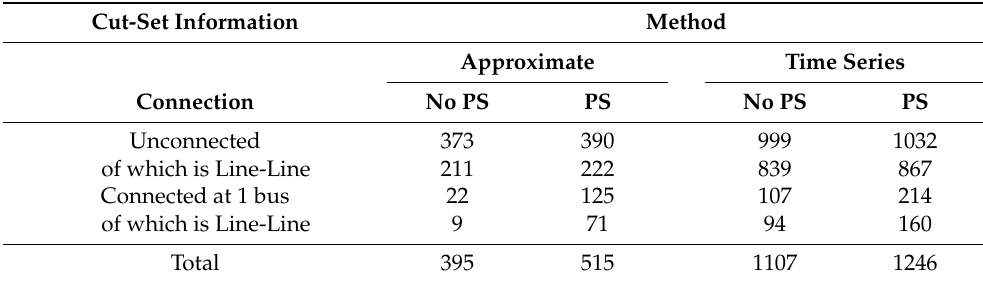
Table 3. Energy Not Supplied (ENS) due to second order cut-sets, calculated using different methods; in